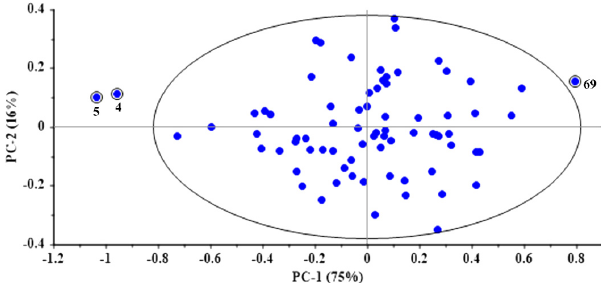
Fig. 5. Score plot of PCA for outlier detection. The ellipse is corresponding to 95% con¯dence.